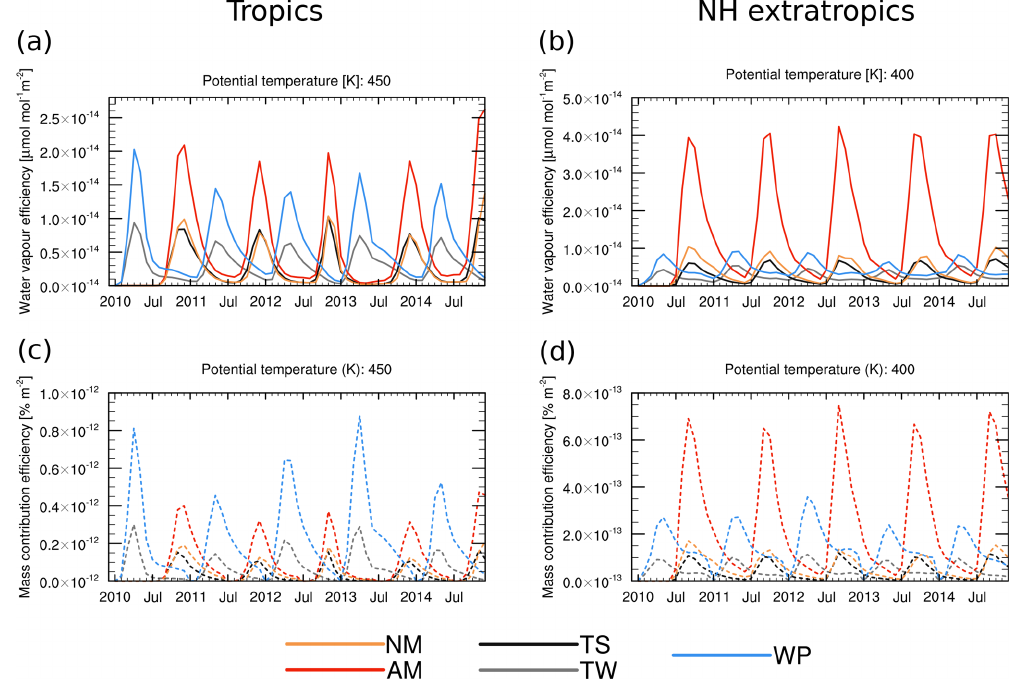
Figure 12. Time series of the mean water vapour efficiency from the different source regions (all in µmolmol − 1 m − 2 ) (a) averaged over the region 10 ◦ S–10 ◦ N at 450K and (b) averaged over the region 50–70 ◦ N at 400K. The colour coding of the source region is as follows: TS (black), TW (grey), WP (light blue), AM (red) and NM (orange). (c, d) As in (a) and (b) but for the mass contribution efficiency (in %m − 2 ). Multiplication of the efficiencies with the size of the respective source regions yields the contributions as shown in Figs. 6b and